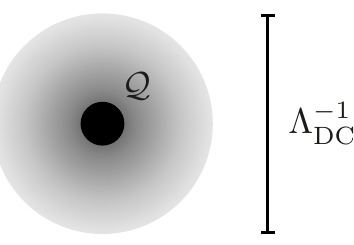
Figure 1 . Cartoon of the gluequark DM candidate. A heavy fermion in the adjoint of color gives rise to color singlet state surrounded by a gluon cloud of size 1 { (cid:3) DC " 1 { M